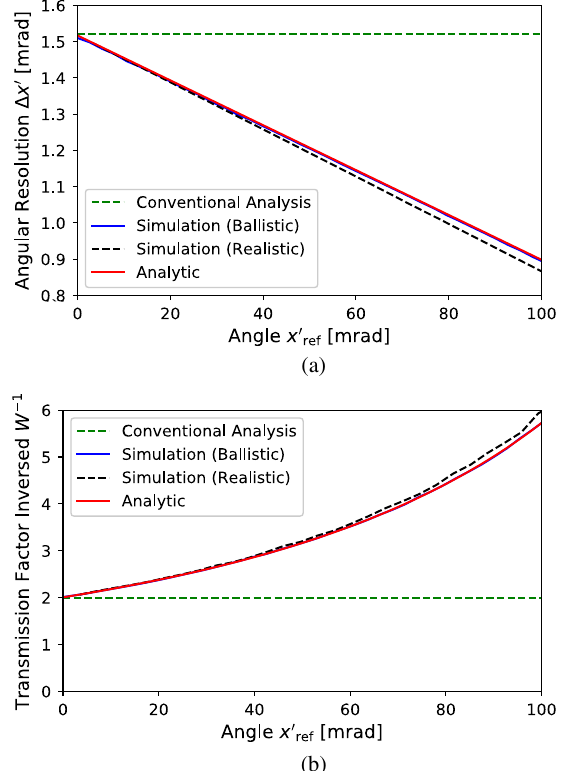
FIG. 6. Plots of (a) angular resolution Δ x 0 , and (b) angular correction factor as a function of x 0 overlays the blue curve (ballistic